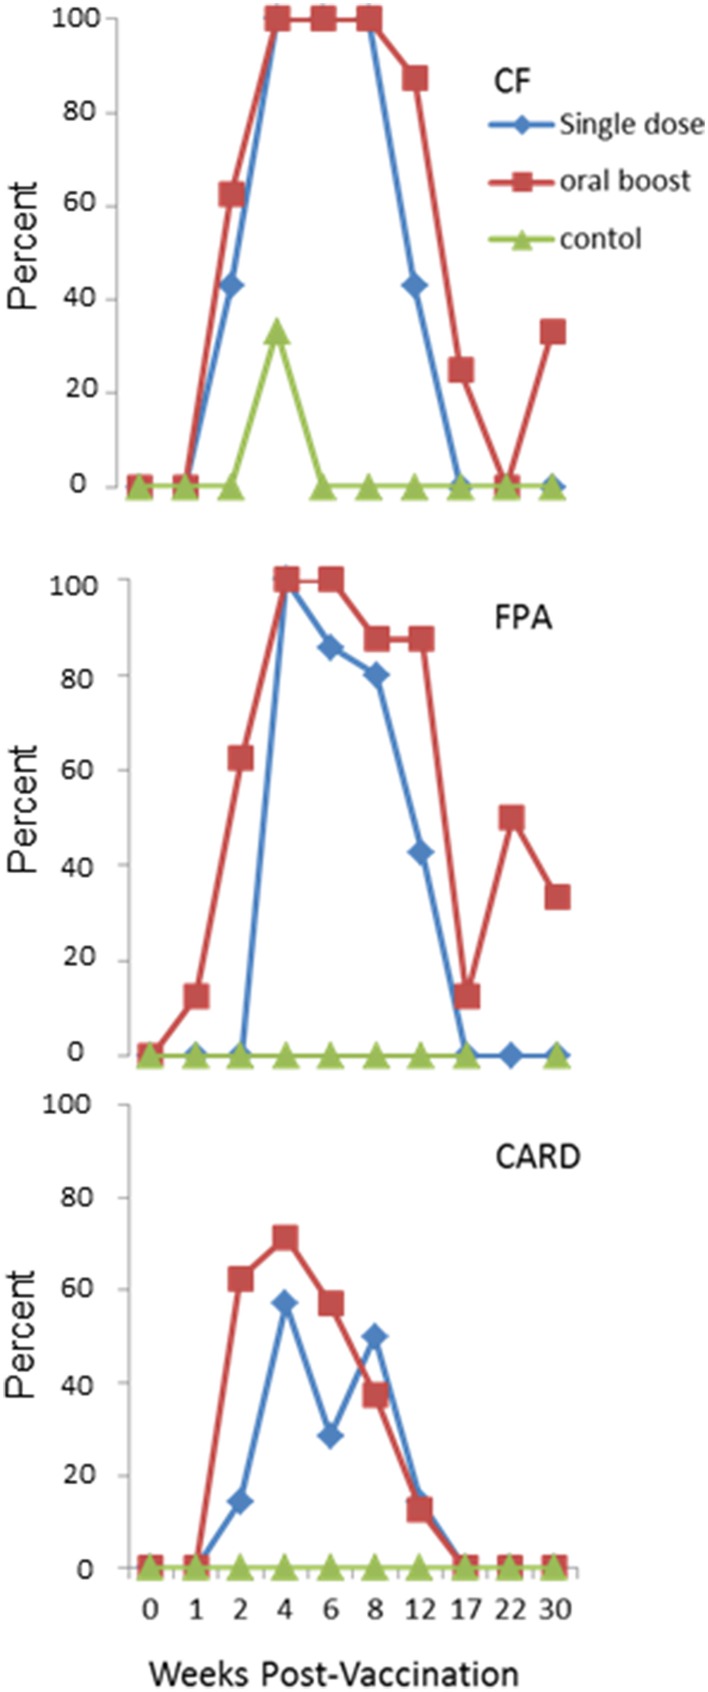
Experiment 1: Percent positive elk in each vaccine group as measured on three standard brucellosis tests at multiple time points: Complement Fixation Assay (CF), Fluorescence Polarization Assay (FPA), and Standard Card Test (CARD). Animals in both vaccination groups developed antibodies that caused positive responses at or after 2 wk post-prime vaccination on all three tests. Positive responses on CF declined after 8 wk post-prime in both vaccine groups. Positive responses to FPA decreased after 4 wk post-prime vaccination in the single dose group and after 6 wk post-prime vaccination in the oral boost group. Positive responses on the CARD test declined after 4 wk post-prime vaccination in both groups. Elk in the single dose and oral boost groups were vaccinated with 2 × 1010 colony forming units sRB51+SODc, WboA intramuscularly (0 wk) and elk in the oral boost group were orally vaccinated with 1 × 1011 colony forming units sRB51+SODc, WboA at wk 6. The control group received phosphate buffered saline intramuscularly.